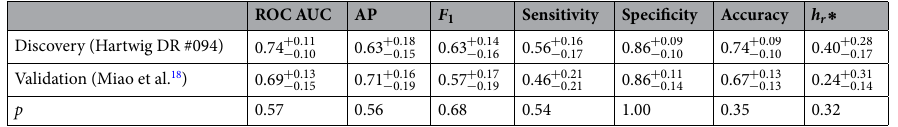
Table 2. Durable benefit (DB) classifier performance metrics and p -value comparing the performance between the two datasets. ROC AUC area under the receiver operating characteristic curve, AP average precision, h r hazard ratio of progression-free survival (PFS) comparing patients predicted DB versus predicted non-DB. Estimates and corresponding 95% confidence intervals are indicated by sub and superscripts. *All patients were included in the PFS analysis. For all other classification metrics, only patients where censoring permitted unambiguous DB label assignment were